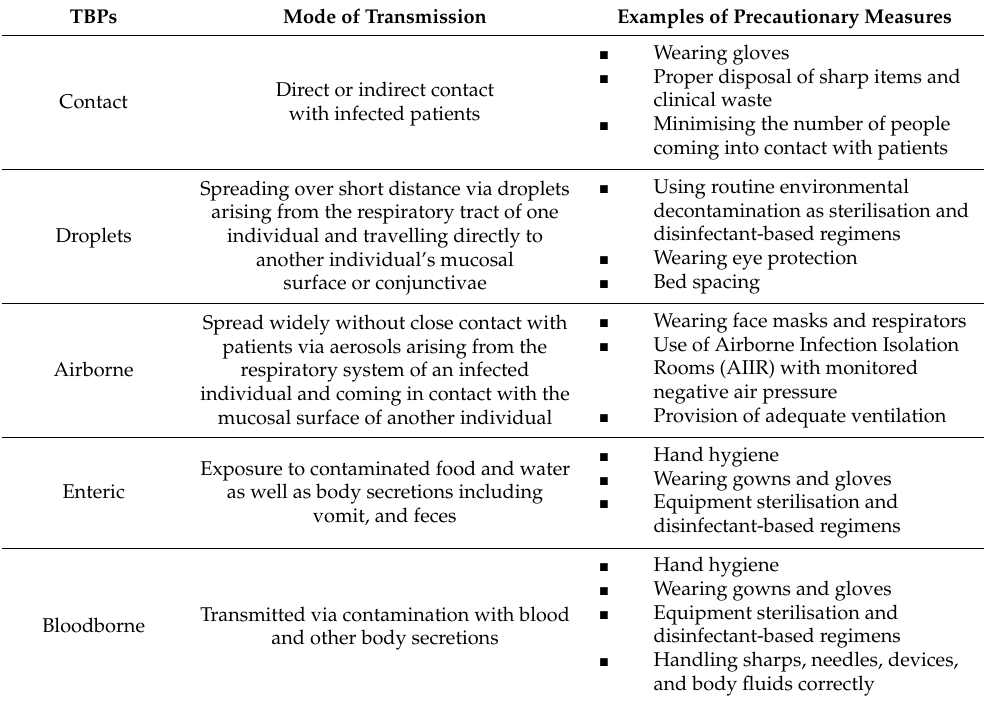
Table 1. Common types of TBPs based on the route of transmission of the infectious agent [24,39–44]. TBPs Mode of Transmission Examples of Precautionary